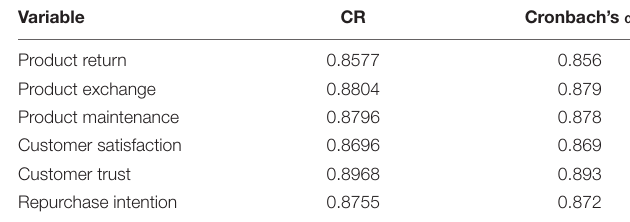
TABLE 3 | Reliability indices for